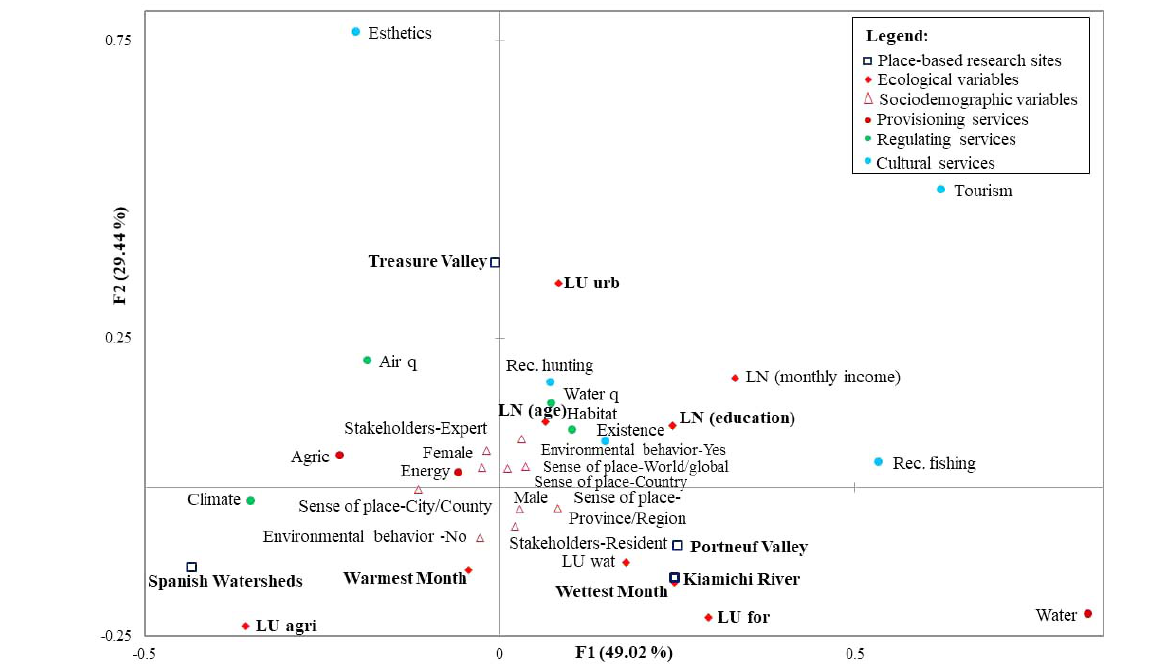
Fig. 3. RDA analysis across the four place-based research sites. The biplot shows the relationships between respondents’ perceptions toward particular ecosystem services and variables related to respondents’ characteristics (i.e., sociodemographic variables), ecological variables, and place-based research sites. Variables in bold represent explaining variables with higher standardized canonical coefficients for axes 1 and 2. Detail legend: circles = ecosystem services; triangles = sociodemographic variables of respondents; diamonds = ecological variables of SES sites; squares = SES research sites.